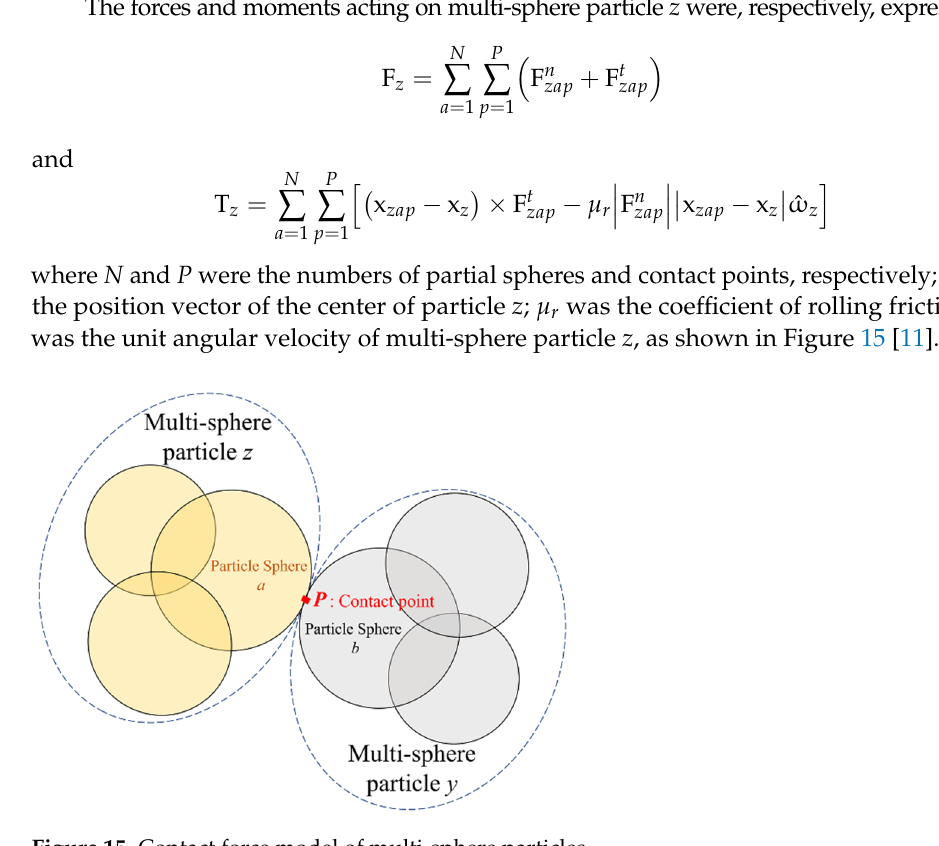
Figure 15. Contact force model of multi-sphere